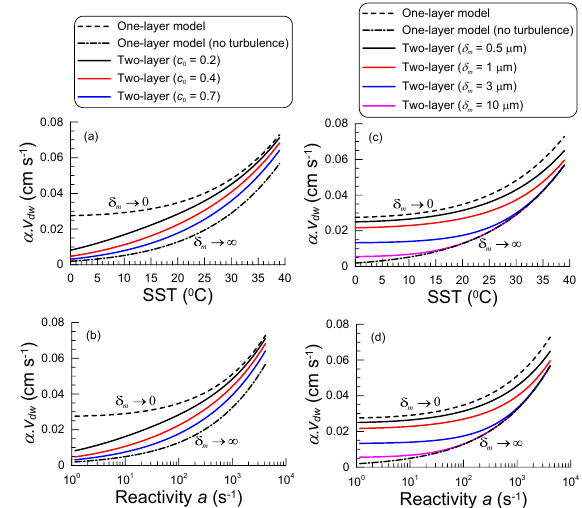
Figure 3. Variation in the waterside component of ozone dry depo- sition velocity multiplied by ozone solubility, αv dw ( = 1 /r c ) , as a function of sea surface temperature (SST, ◦ C) (a, c) and reactivity a (s − 1 ) (b, d) . Curves determined using the two-layer deposition scheme (Eq. 16) for several c 0 values used in δ m = c 0 l m (a, b) and several δ m values (c, d) . The variations obtained using the one-layer deposition scheme with (Eq. 18) and without (Eq. 19) waterside turbulent transfer (i.e. reaction–diffusion only) are also shown. The waterside friction velocity ( u ∗ w ) used was 0.01ms − 1 .